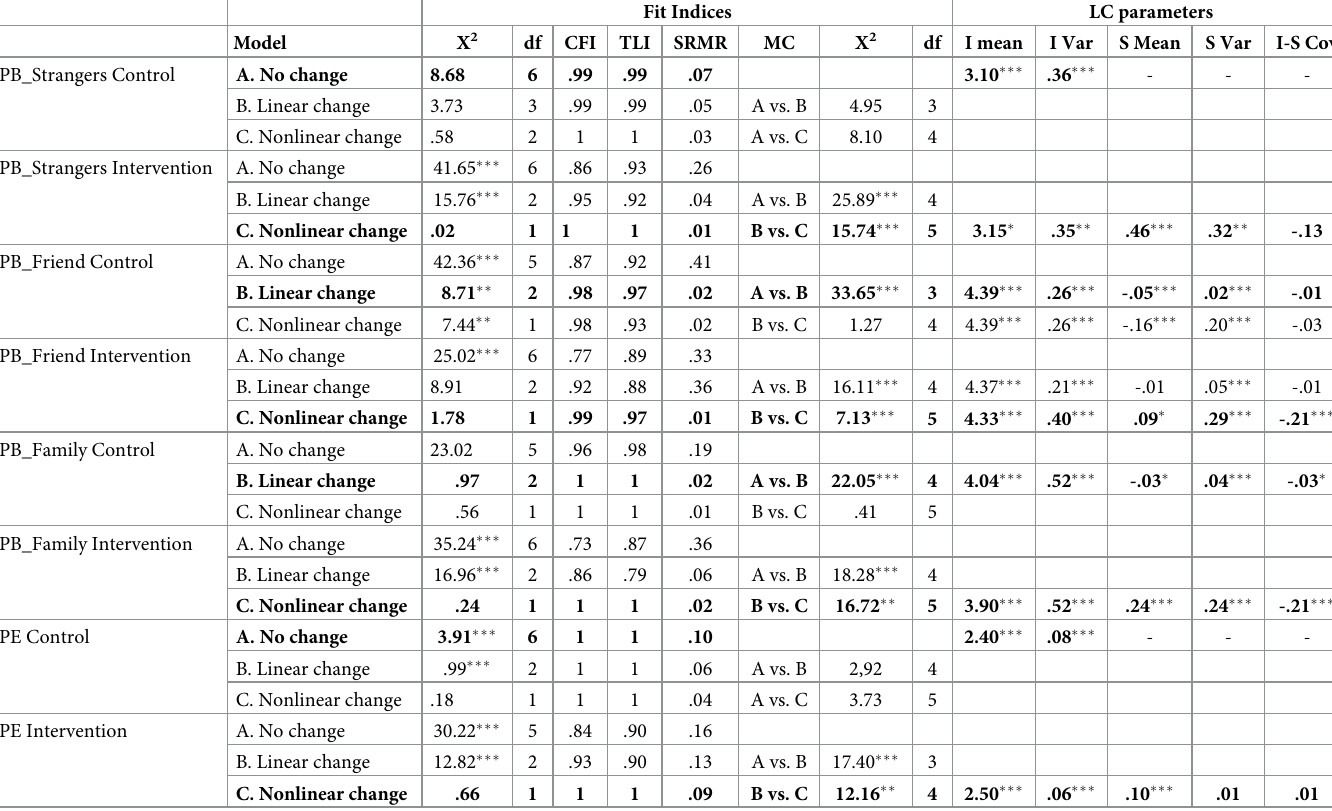
Table 2. Fit indices and parameter estimates for the control and intervention groups.